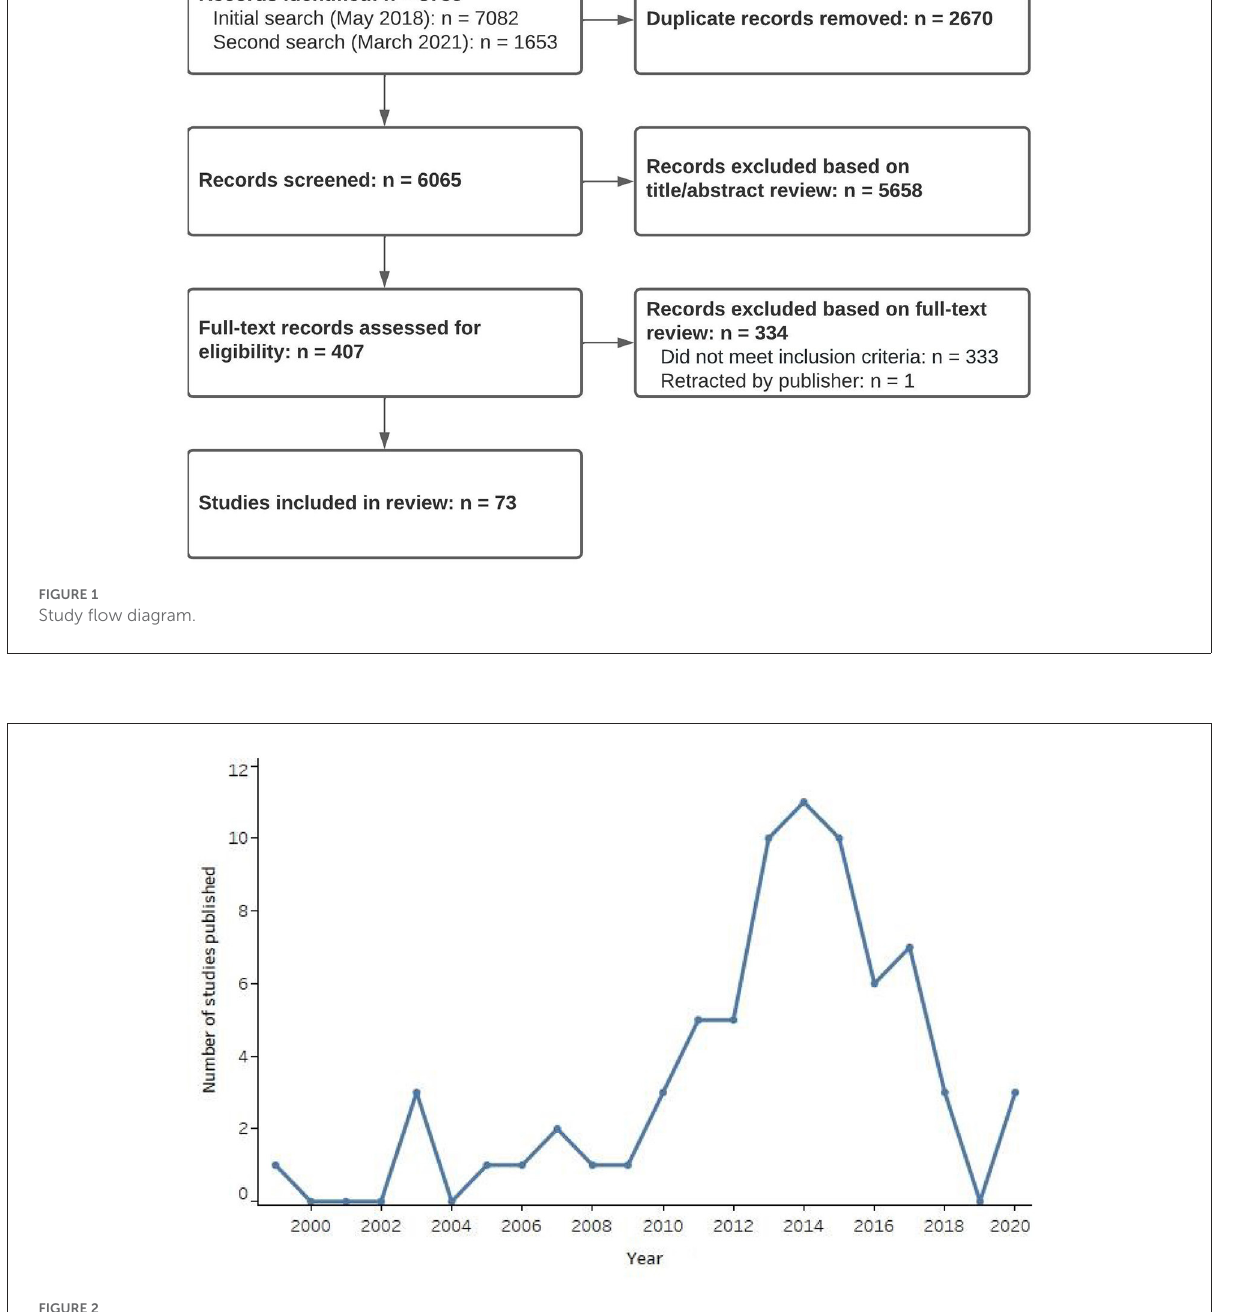
performance (Patel and Azzam, 2005; Enriquez-Geppert et